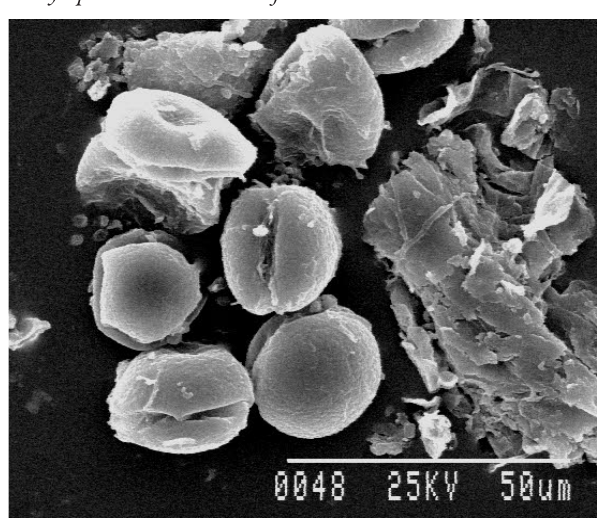
Fig. 16. X1000, showing dimorphic pollen grains of Nymphaea stellata var. major F. Mueller